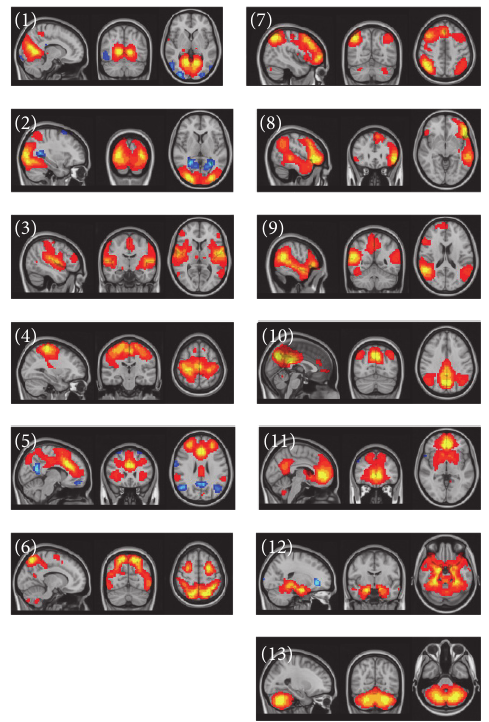
Figure 4: Resting-state networks estimated with ICA. The images are 𝑧 statistics of the concatenated dataset for the controls and the stroke patients decomposed into the independent network compo- nents: primary visual (1), lateral visual cortex (2), auditory cortex (3), sensory-motor cortex (4) network associated with salience pro- cessing (5), task positive network involved in higher-order cognition and attention (6), networks implicated in working memory and cognitive attentional processes as right lateral network (7), and left lateral frontoparietal network (8), ventral stream ventral attention system (9), posterior component of the default mode network in the precuneus and parietal regions (10), anterior component of the default mode network in the frontal pole and precuneus (11), medial temporal/the hippocampus amygdala complex (12), and cerebellar network (13).